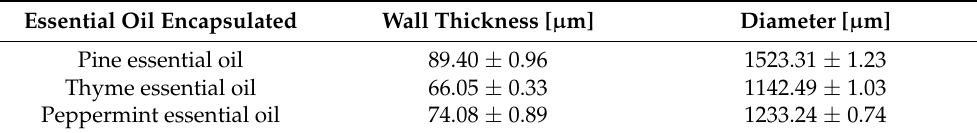
Table 5. Characteristics of microcapsules loaded with pine, thyme, and peppermint essential oils.